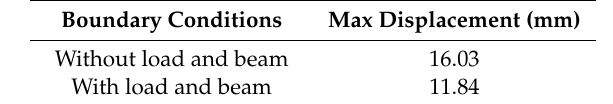
Table 4. Results of Case study #1.